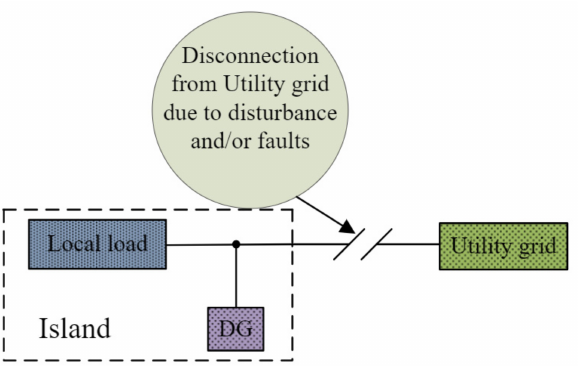
Figure 5. Schematic diagram of the distributed generation (DG)